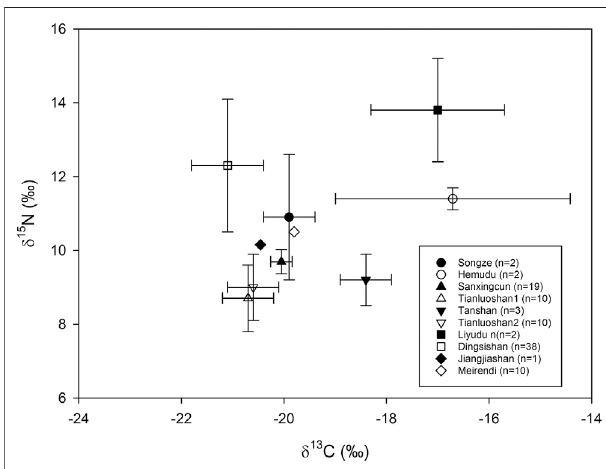
FIGURE 2 | The error bar plot of human bones in LYRR and South